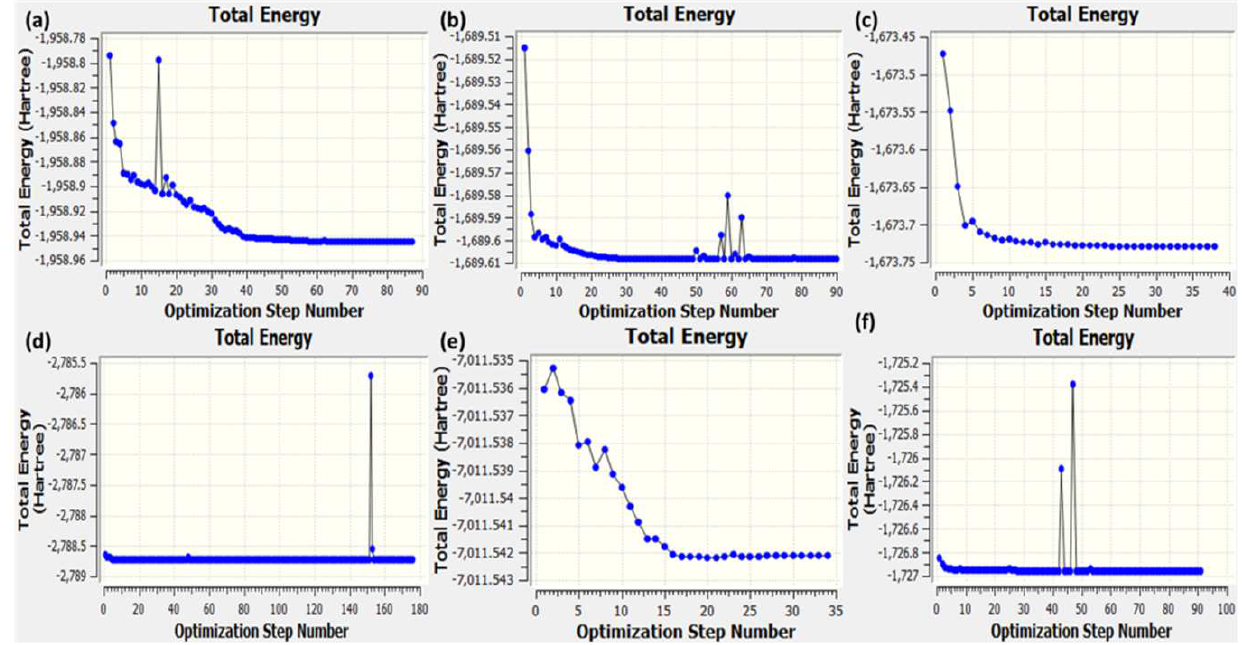
Figure 18. Optimization step graph for ( a ) [(SRX)(PA}], ( b ) [(SRX)(DNB), ( c ) [(SRX)(p-NBA)], ( d ) [(SRX)(DCQ)], ( e ) [(SRX)(DBQ)], and ( f ) [(SRX)(TCNQ)] . Table 4. Theoretical molecular parameters of the CT complexes obtained through DFT. Electronic Minimum SCF Dipole Moment ∆ E CT Complex Spatial Extent Energy (a.u.) (Debye) (a.u.)